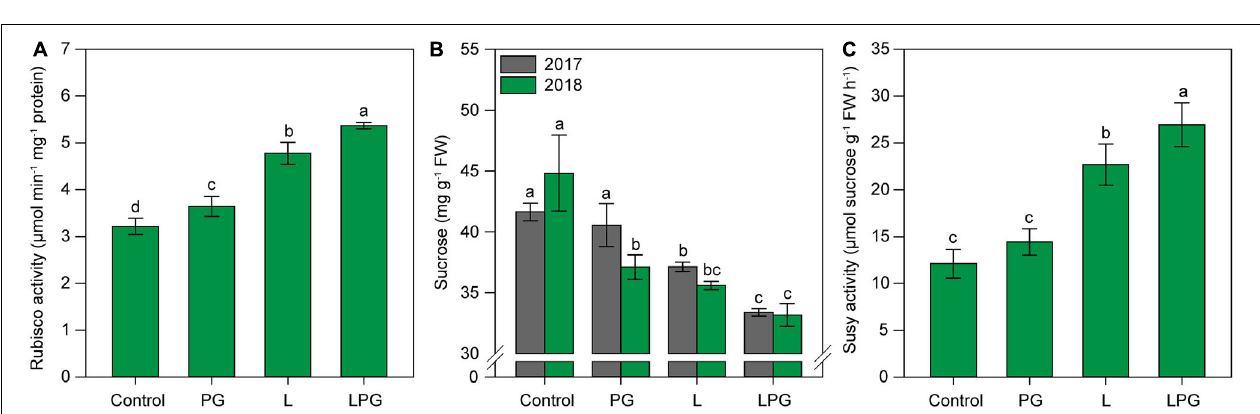
FIGURE 6 | Net photosynthesis rate– A (A) , stomatal conductance– gs (B) , internal CO 2 concentration– ic (C) , and water use efficiency–WUE (D) in maize leaves as affected by surface-applied lime (L), phosphogypsum (PG), and lime + phosphogypsum (LPG) treatments. Different lower-case letters indicate significant differences between treatments for each growing season by Student’s t -test at p ≤ 0.05. Error bars express the standard error of the mean ( n = 4).